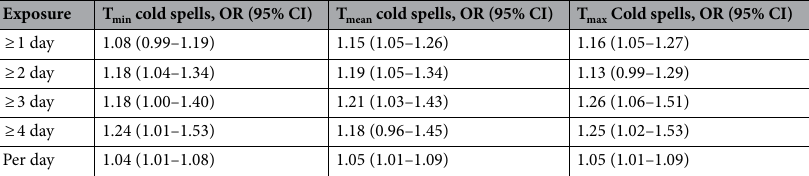
Table 4. Results of the sensitivity analyses using daily minimum and maximum, instead of daily mean, temperature in the definition and assessment of cold spells, expressed as odds ratios and 95% confidence intervals.